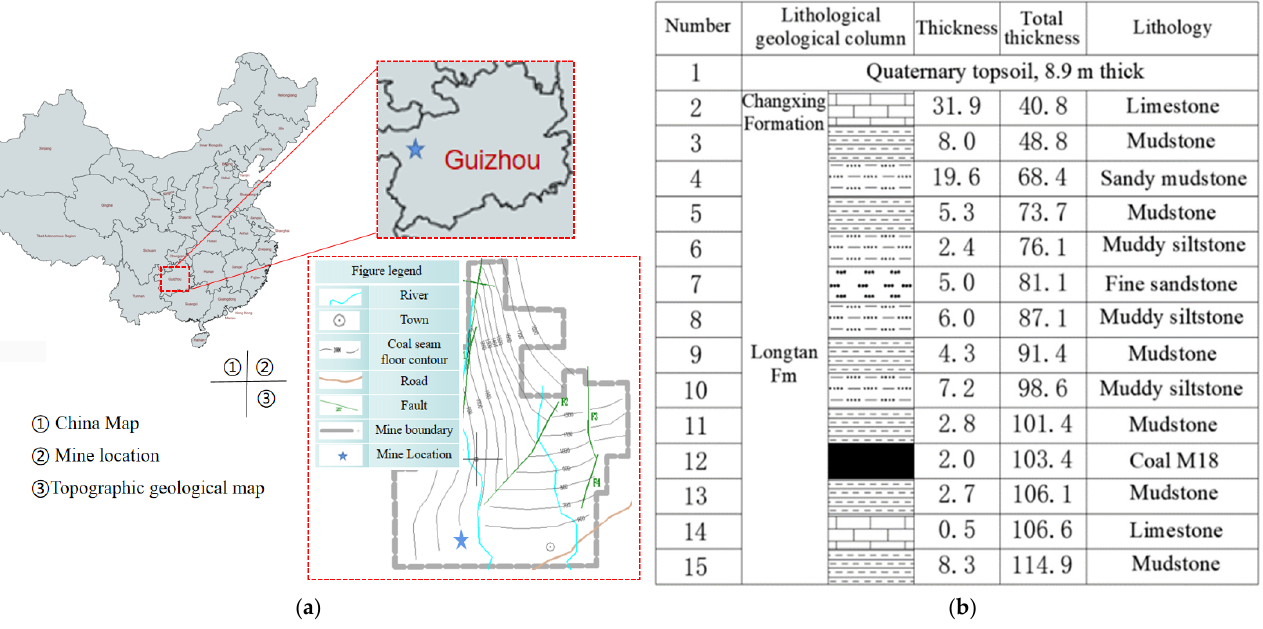
Figure 1. Project background. ( a ) Mine location; ( b ) Comprehensive histogram of coal strata.